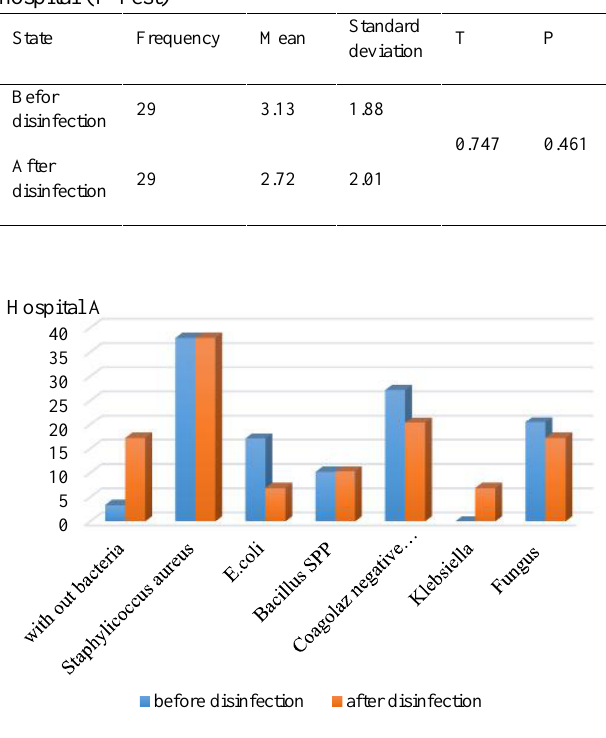
Fig. 1. Bacterial species in hospital A samples before and after disinfection